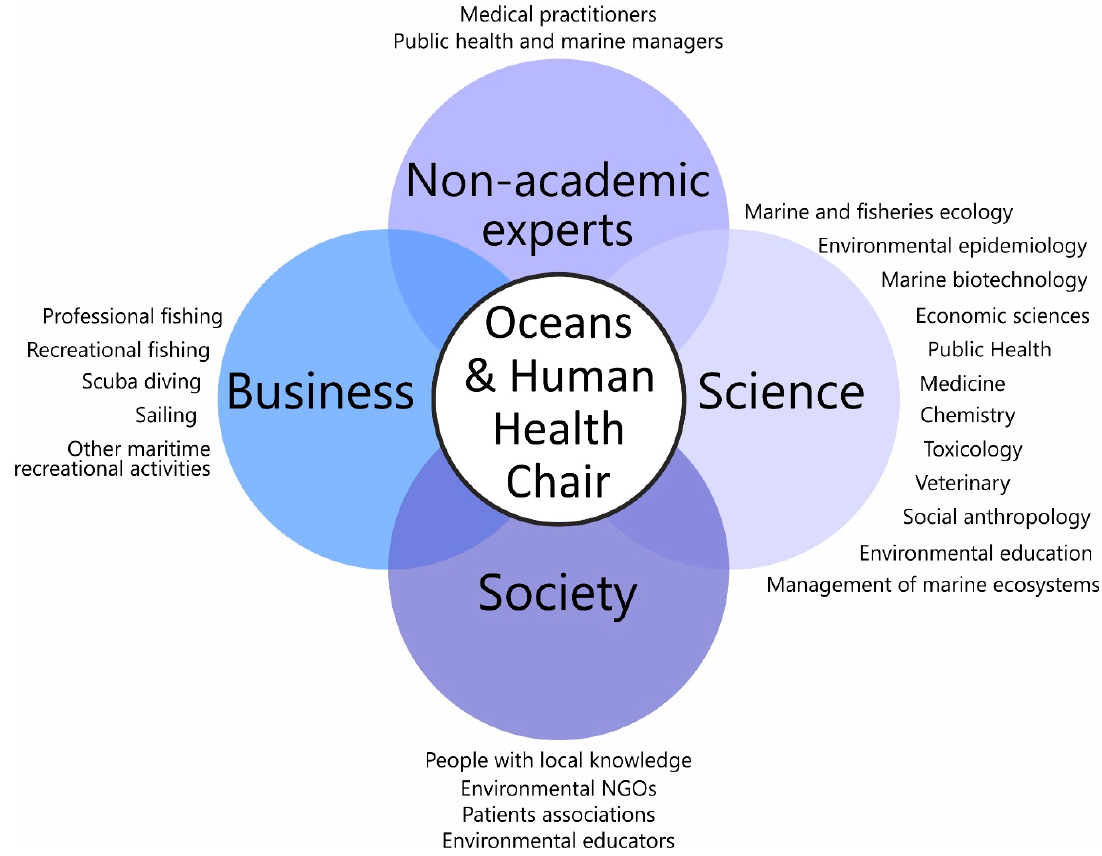
Figure 2. The fundamentals of the Oceans and Human Health Chair in Roses.